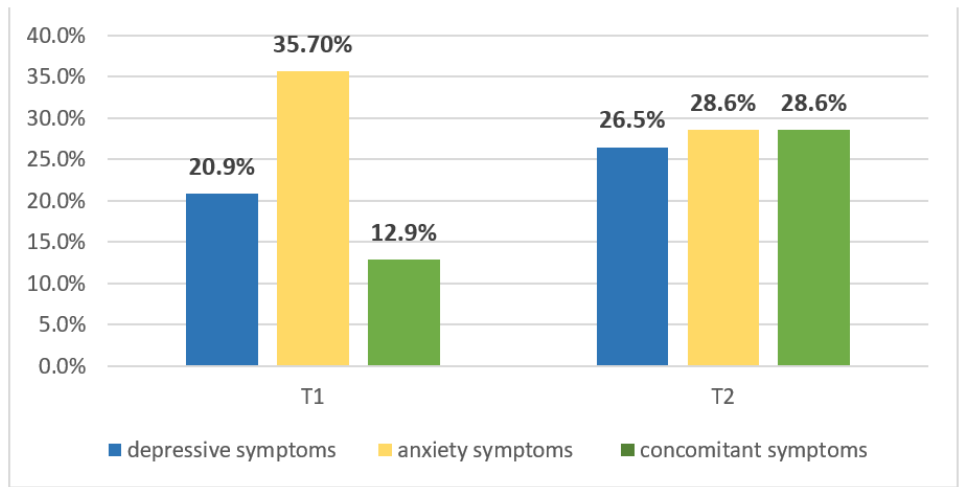
Figure 1. T1, after surgery and before chemoradiotherapy; T2, 1 year after chemoradiotherapy completion